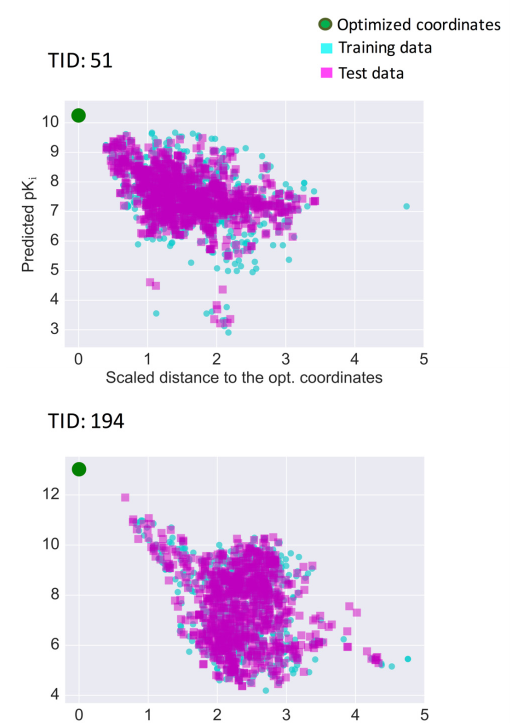
values are related to the scaled distance of the corresponding i